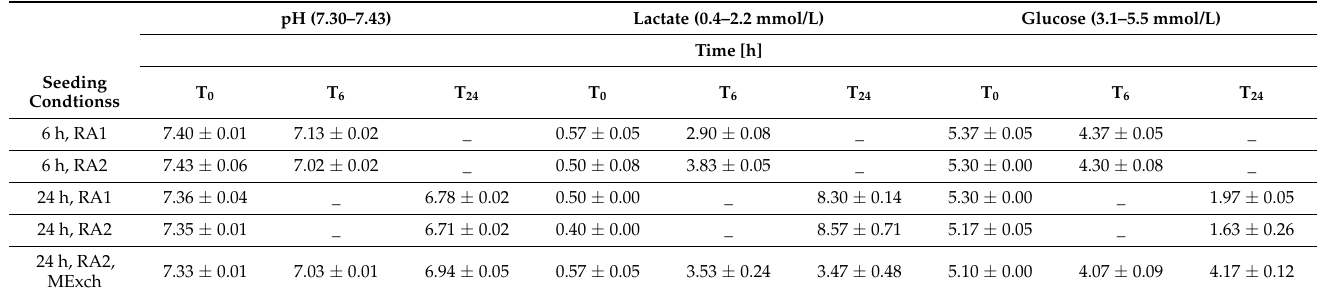
Table 1. Analysis of pH, lactate and glucose in cell medium at different time points during different seeding conditions. Values are provided as means with standard deviation (SD) from independent triplicates. Reference values for venous blood, as prospectively perfused through the BHL, are in brackets [30]. RA1: rotational axis 1, RA2: rotational axis 2, MExch: medium exchange.